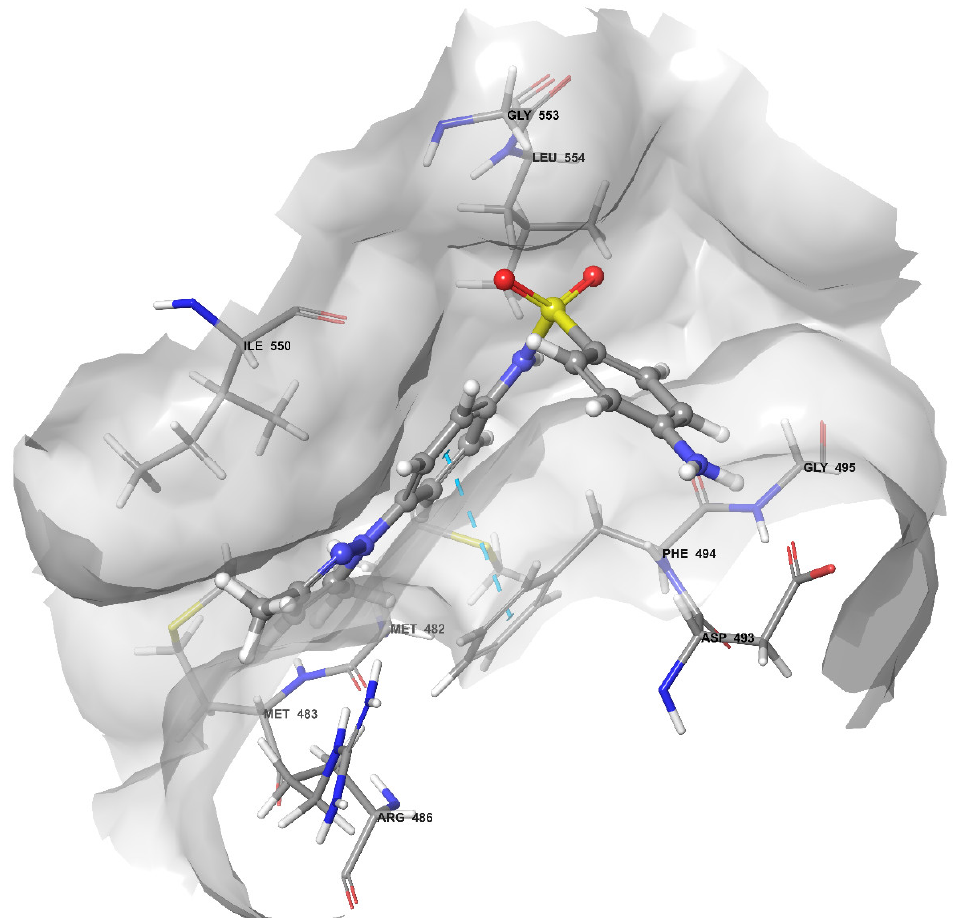
Figure 4. Binding mode of the best docking pose of 2C after the docking study. The light blue, dashed lines represent the pi–pi stacking. The displayed residues establish positive vdW contacts with the compound.